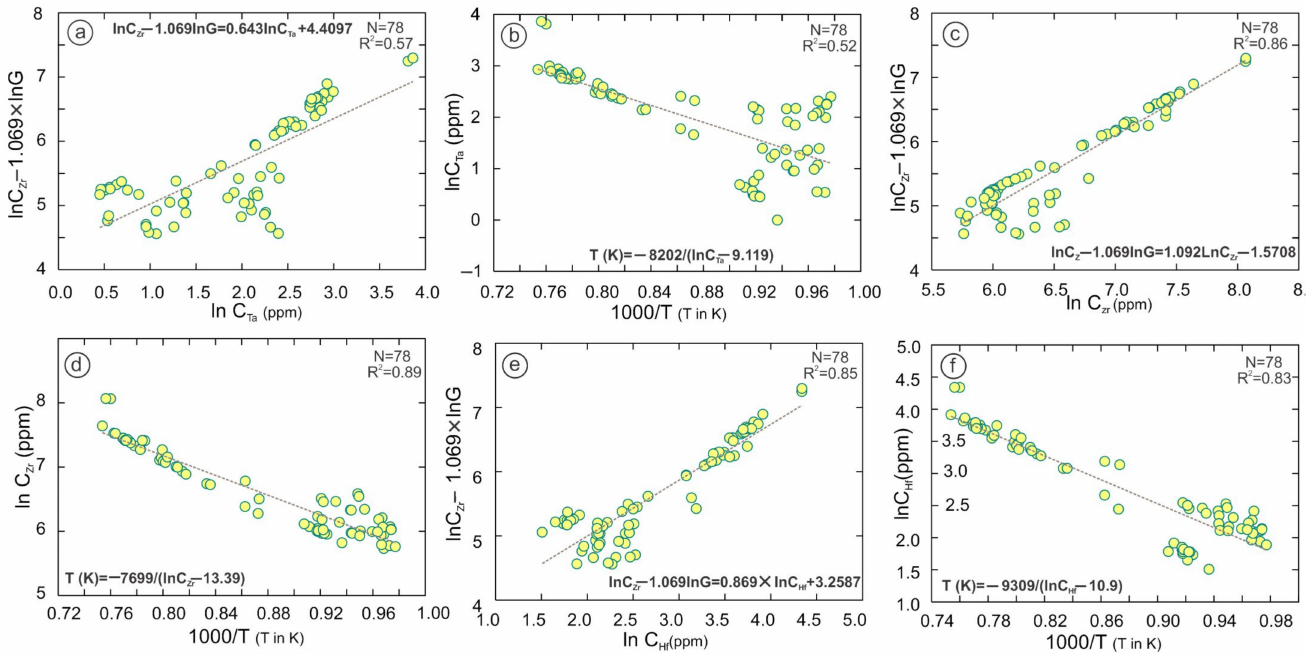
Figure 10. ( a – f ) Plot lnC Ta , lnC Zr , and lnC Hf versus the lnCZr–1.069lnG and 1000/T in the peralkaline to alkaline rocks which is showing a clear correlation except for C Ta